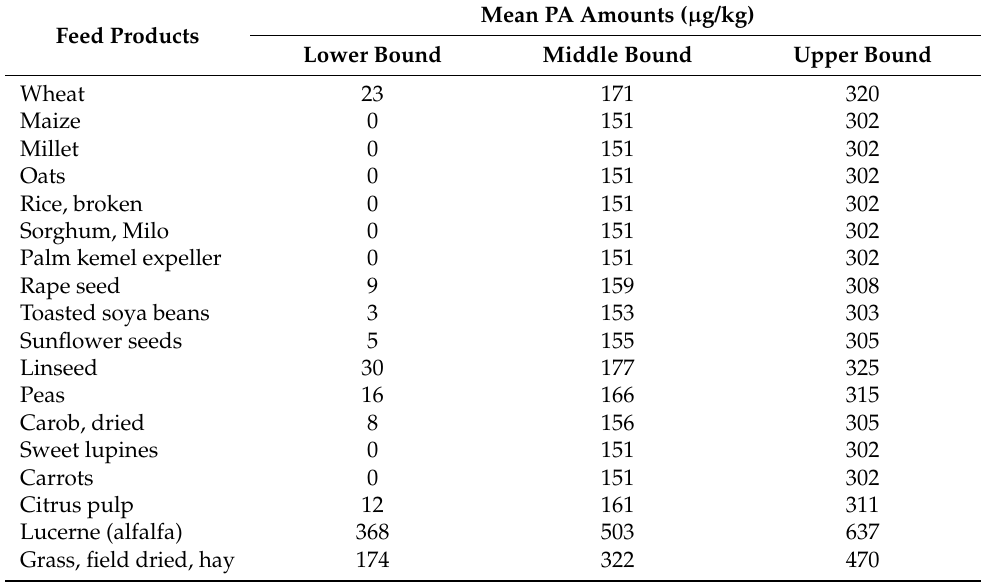
Table 1. Amounts of PAs in feed